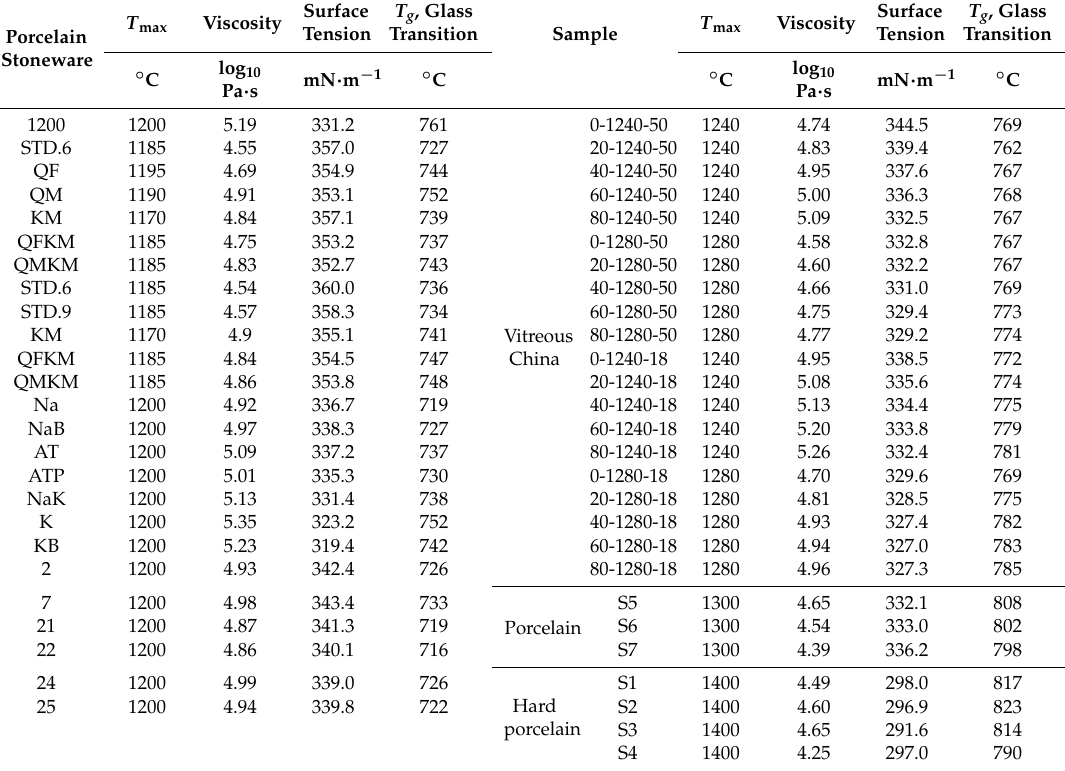
Table 2. Physical Properties at T max of the vitreous phase in porcelain-like bodies.